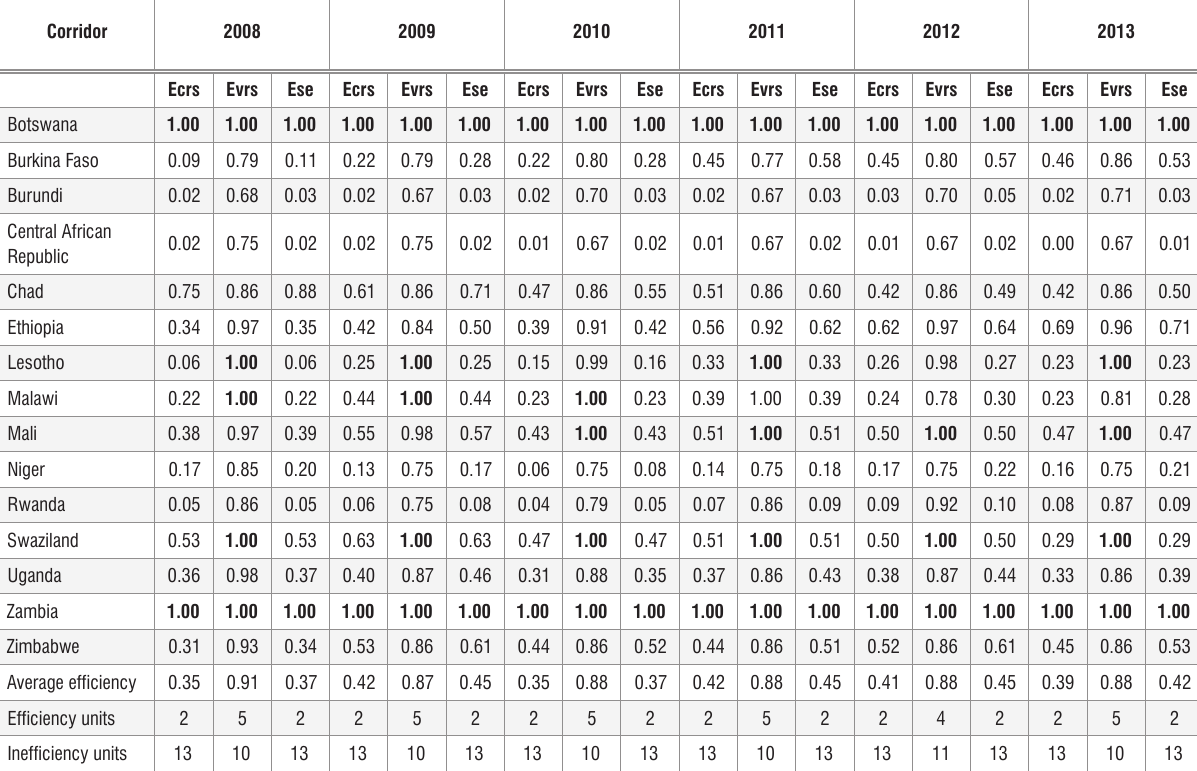
Efficiency scores (‘pure’ technical - Evrs, scale - Ese and technical - Ecrs) for 15 corridors, 2008–2013